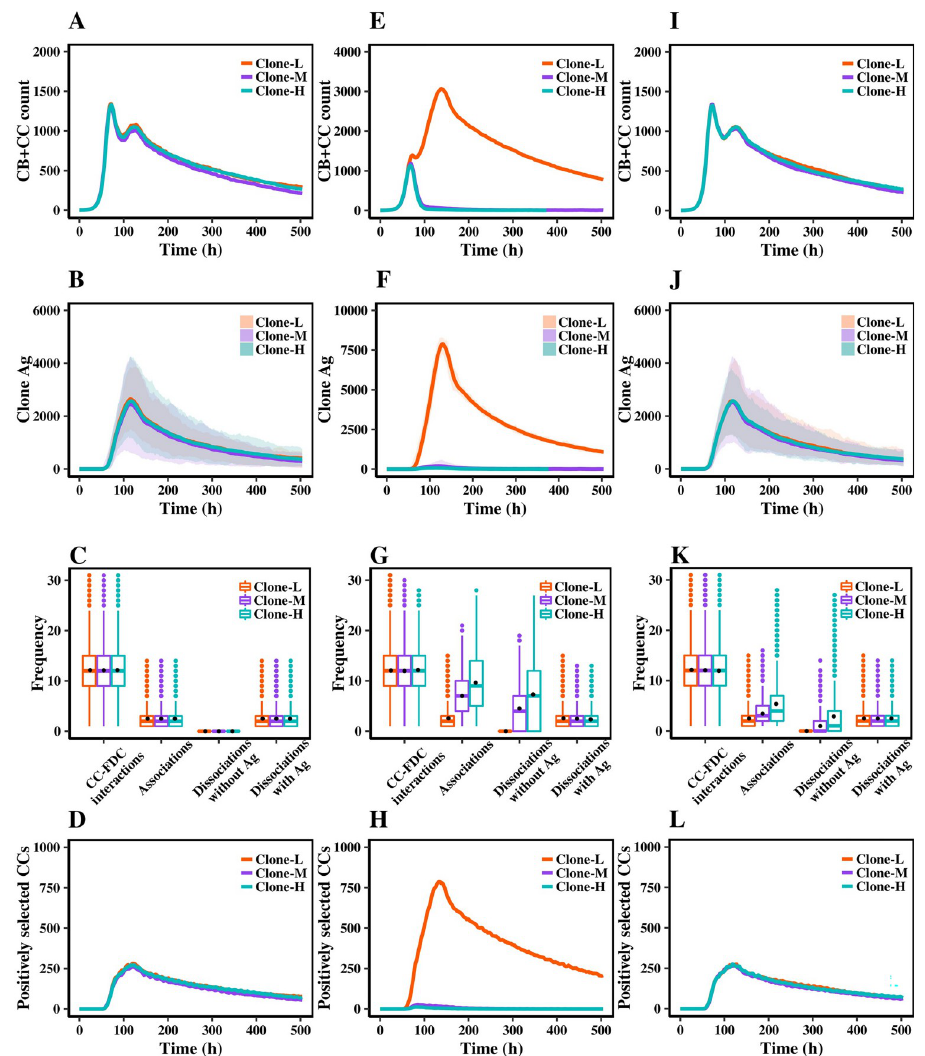
Fig 3. Dynamics of population and Ag collection phase. Results are obtained from 30 simulations. (A) The average of CB+CC counts for each clone in the reference scenario (Scenario-0). (B) Collected Ag for each clone during the GC reaction in the reference scenario. This consists of Ags collected by all CCs in each clone. Lines represent averages. The shaded area denotes the minimum and maximum values in all repeats. (C) Events during the Ag collection phase for CCs that attend the Tfh selection phase in the reference scenario. CC-FDC interactions denote the events at which the CC is located at an Ag binding site on a FDC. Boxplots are produced based on combined data of all simulations. Black dots represent average values per cell in each clone over all repeats. (D) The population of CCs that are positively selected by Tfh cells. Solid lines represent the average of all simulations. (E), (F), (G), and (H) represent the results of Scenario-1. (I), (J), (K) and (L) represent the results of Scenario-2. Panel descriptions are similar to that of the reference